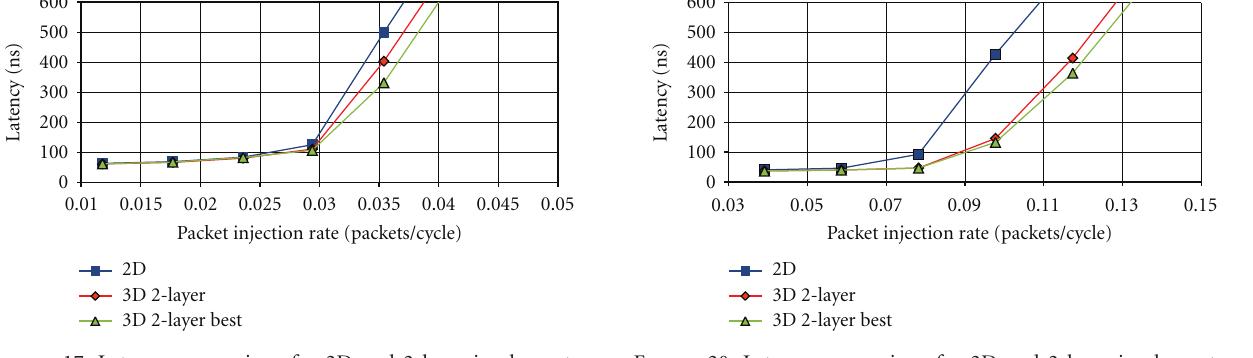
Figure 17: Latency comparison for 2D and 2-layer implementa- tions of apte .